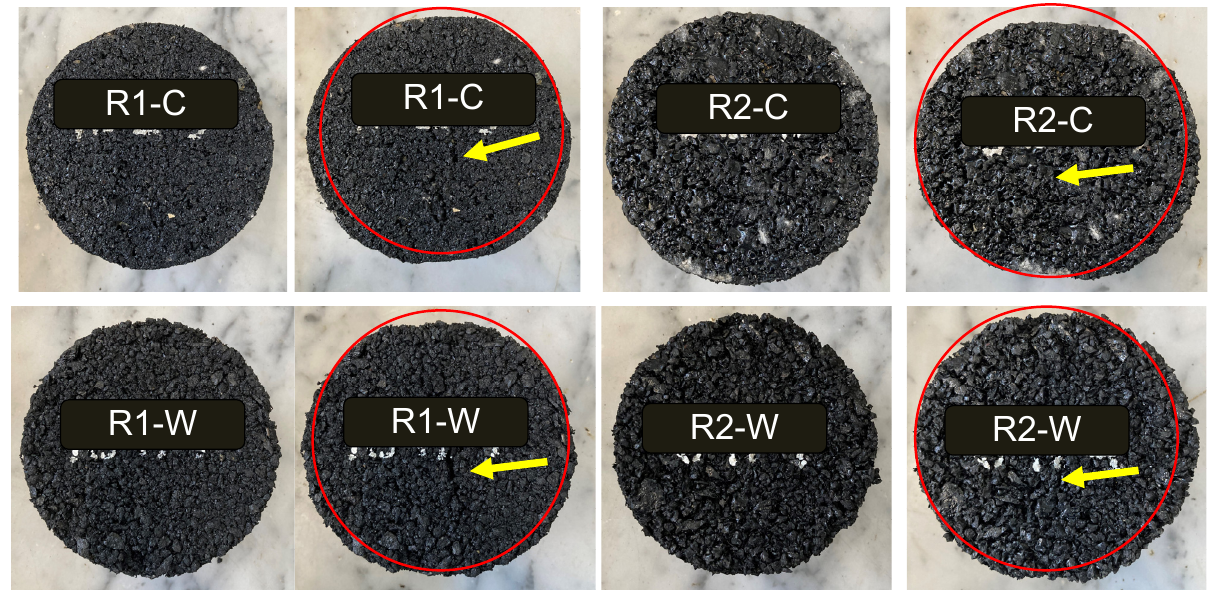
Figure 7. Comparison of the samples after 10 F–T cycles. On the left, the samples before ITS test; on the right, samples after testing. The red circle represents the sample’s deformation, and the arrow highlights the crack visible on the samples.